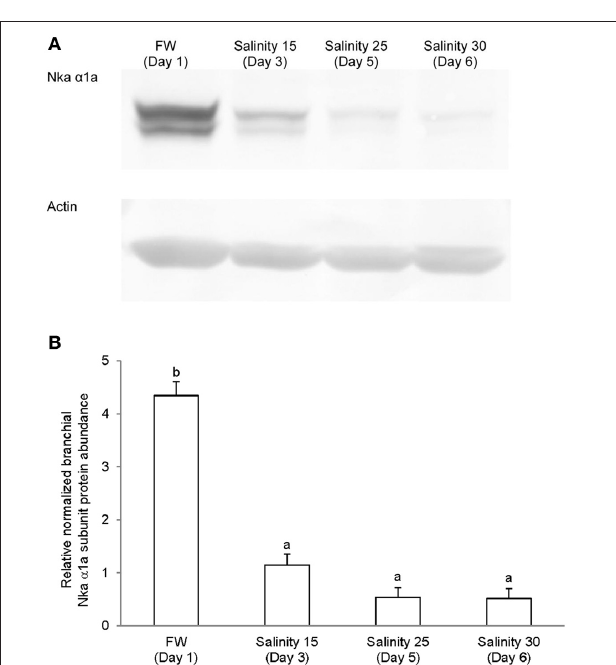
to S 10 on day 2, S 20 on day 4, S 25 on day 5 and S 30 (seawater) on day 6, and then kept in seawater for another 6 days (day 11). Results are presented as means ± S.E.M ( N = 5). Means not sharing the same letter are significantly different ( P < 0 . 05).